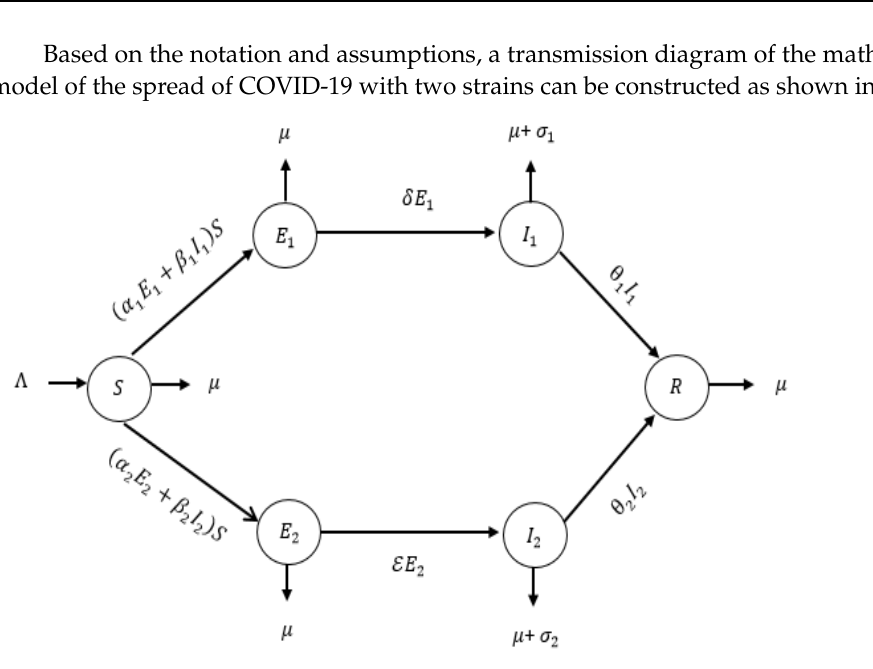
Figure 1. Transmission diagram of the COVID-19 model with two